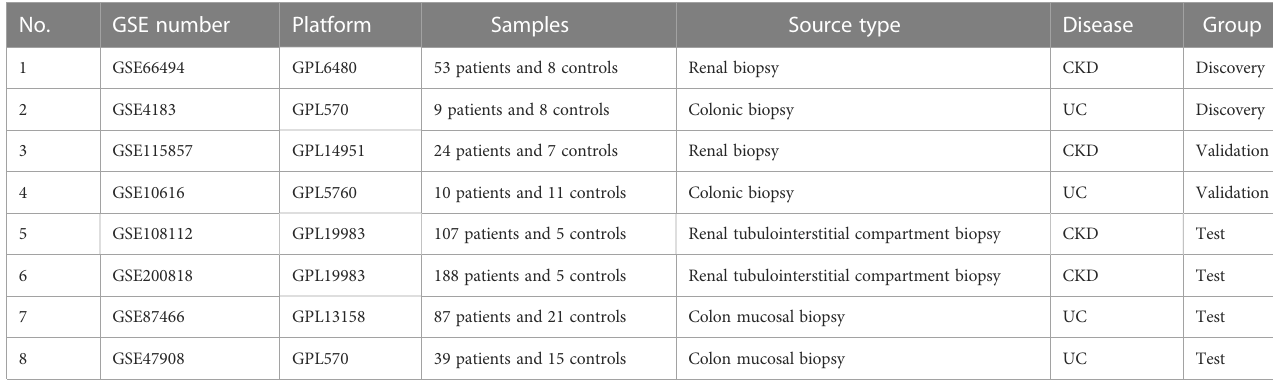
TABLE 1 Summary of eight GEO datasets involving CKD and UC patients.